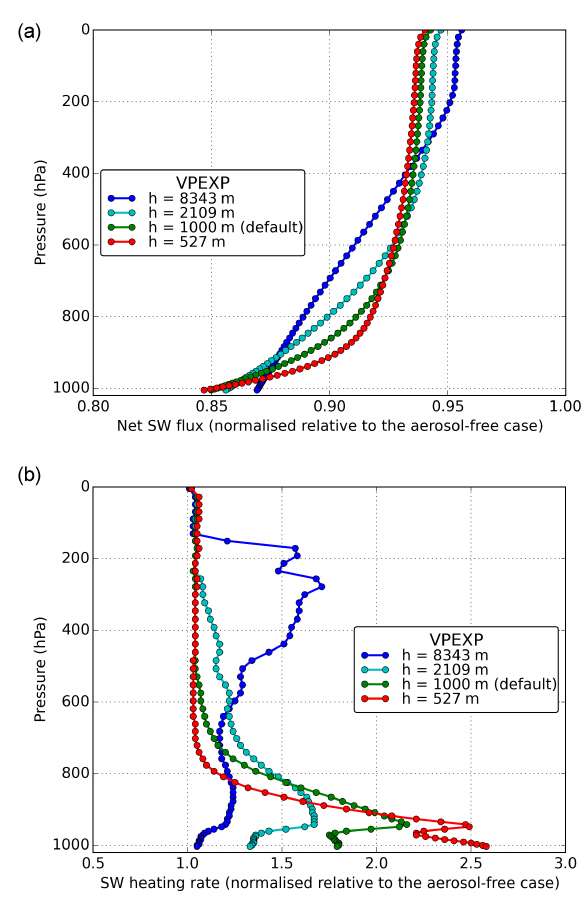
Figure 7. (a) Net SW radiation fluxes (normalised relative to the aerosol-free case) as a function of atmospheric pressure for four ver- tical scale heights ( h ) of IFS land aerosols. (b) Similar to panel (a) but shows the normalised SW heating rate. The experiments were carried out using the IFS radiation